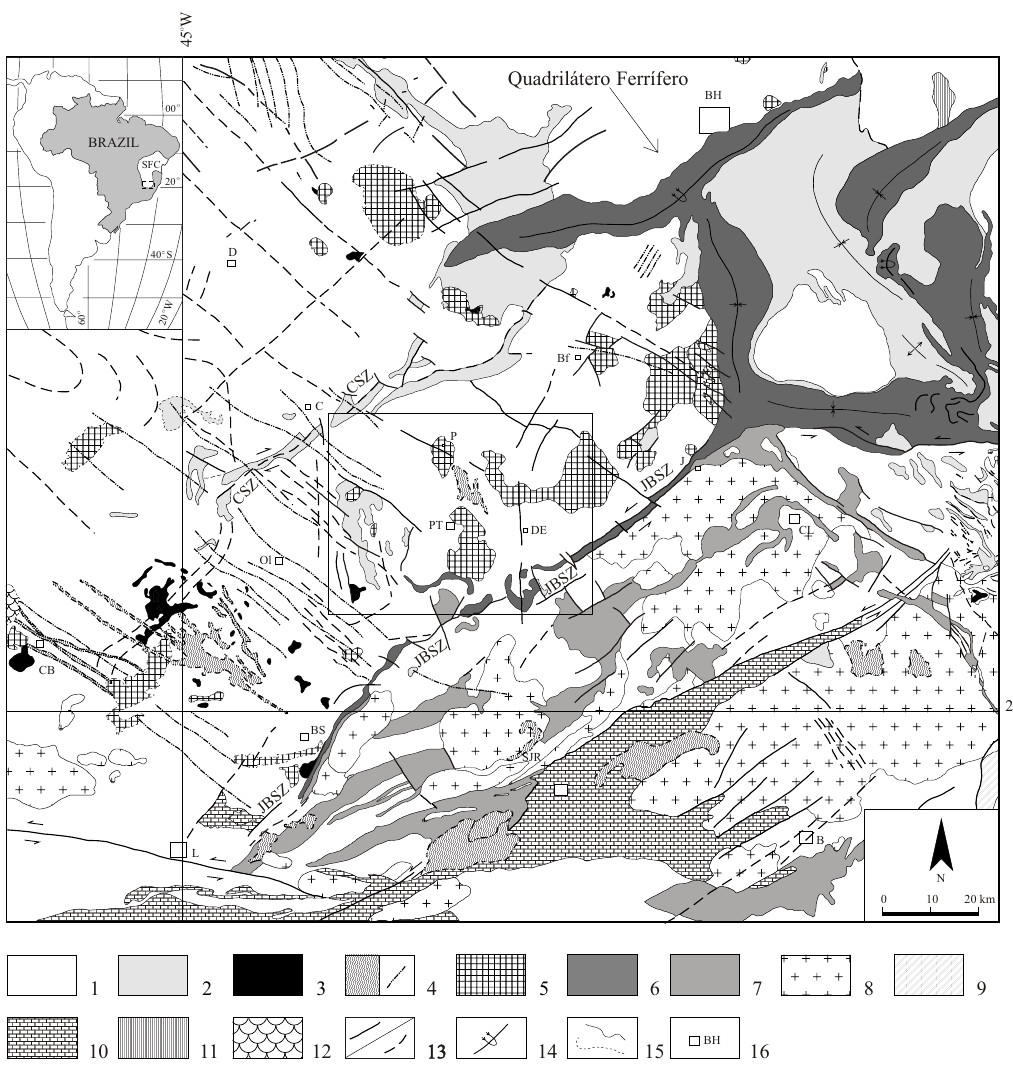
Fig. 1–GeologicalmapofthesouthernSãoFranciscoCraton,pointingtheQuadriláteroFerríferoregionandPassaTempoMetamorphic Complex (assinalated rectangle) detailed in Figure 2. Key: 1 – Archean metamorphic complexes, partially reworked on Proterozoic time; 2 – Neoarchean Rio das Velhas Supergroup; 3 – Neoarchean ultramafic plutonic suite; 4 – Neoarchean and Mesoproterozoic gabbroic and dioritic rocks (sills and dikes); 5 – Neoarchean granitoids; 6 – Paleoproterozoic Minas Supergroup; 7 – Paleoproterozoic indiscriminate greenstone-type sequences; 8 – Paleoproterozoic granitoids; 9 – Mesoproterozoic (?) Dom Silvério Group; 10 – Mesoproterozoic (?) São João Del Rei/Andrelândia Groups; 11 – Mesoproterozoic Espinhaço Supergroup; 12 – Neoproterozoic undivided cratonic cover; 13 – Faults and fractures (CSZ = Cláudio Shear Zone; JBSZ = Jeceaba-Bom Sucesso Shear Zone); 14 – Fold axes; 15 – Lithologic contacts; 16 – Cities: B = Barbacena, BH = Belo Horizonte, Bf = Bonfim, BS = Bom Sucesso, CB = Campo Belo, C = Cláudio, CL = Conselheiro Lafaiete, DE = Desterro de Entre Rios, D = Divinópolis, J = Jeceaba, L = Lavras, Ol = Oliveira, P = Piracema, PT = Passa Tempo, SJR = São João del Rei [geology modified after Dorr II (1969); Lima et al. (1974); Schorscher et al. (1982); Grossi Sad et al. (1983); Machado Filho et al. (1983); Silva (1985); Quéméneur (1987); Carneiro (1992); Raposo (1991); Brandalise (1991); Endo (1997); Oliveira and Carneiro (2001); Quéméneur and Noce (2000); Paciullo et al. (2000); Fernandes (2000); Jordt-Evangelista et al. (2000); Valeriano et al. (2000); Ávila (2000); Perillo (2000)].